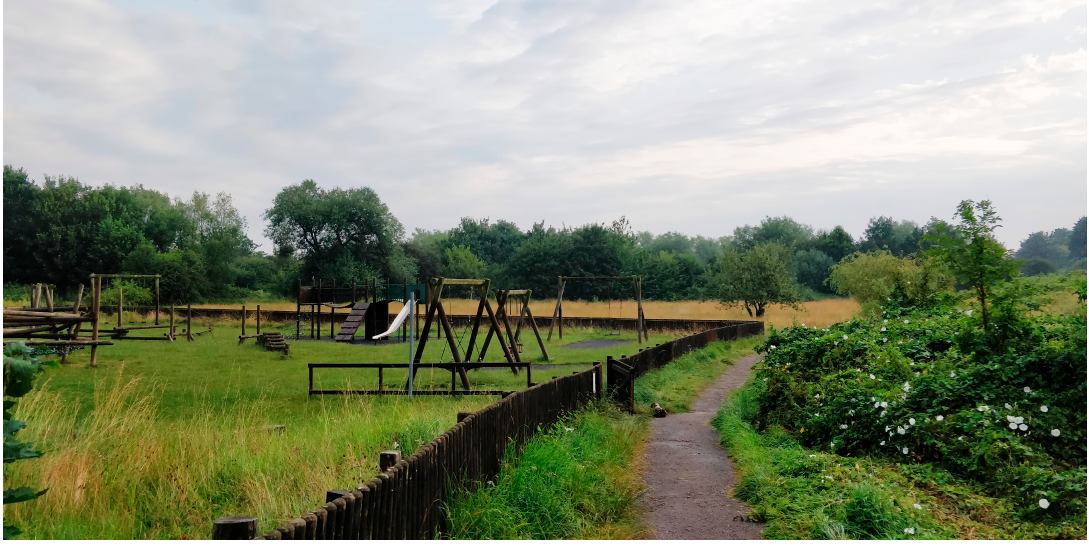
Figure 2. St Nicks Nature Reserve, York.